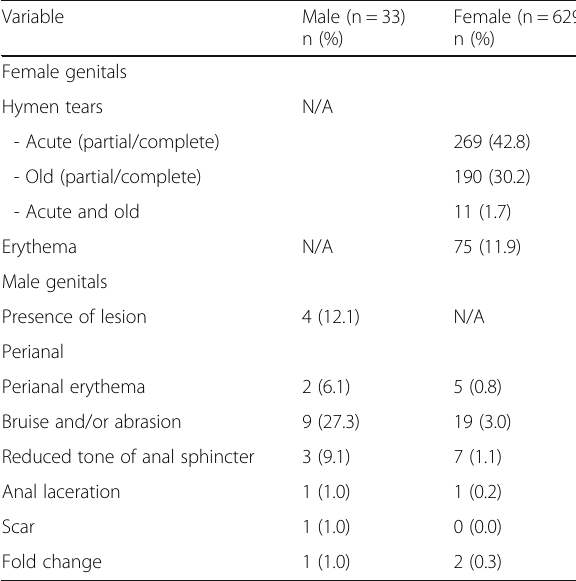
Table 3 Distribution of cases according to bodily injury by gender among sexual violence cases